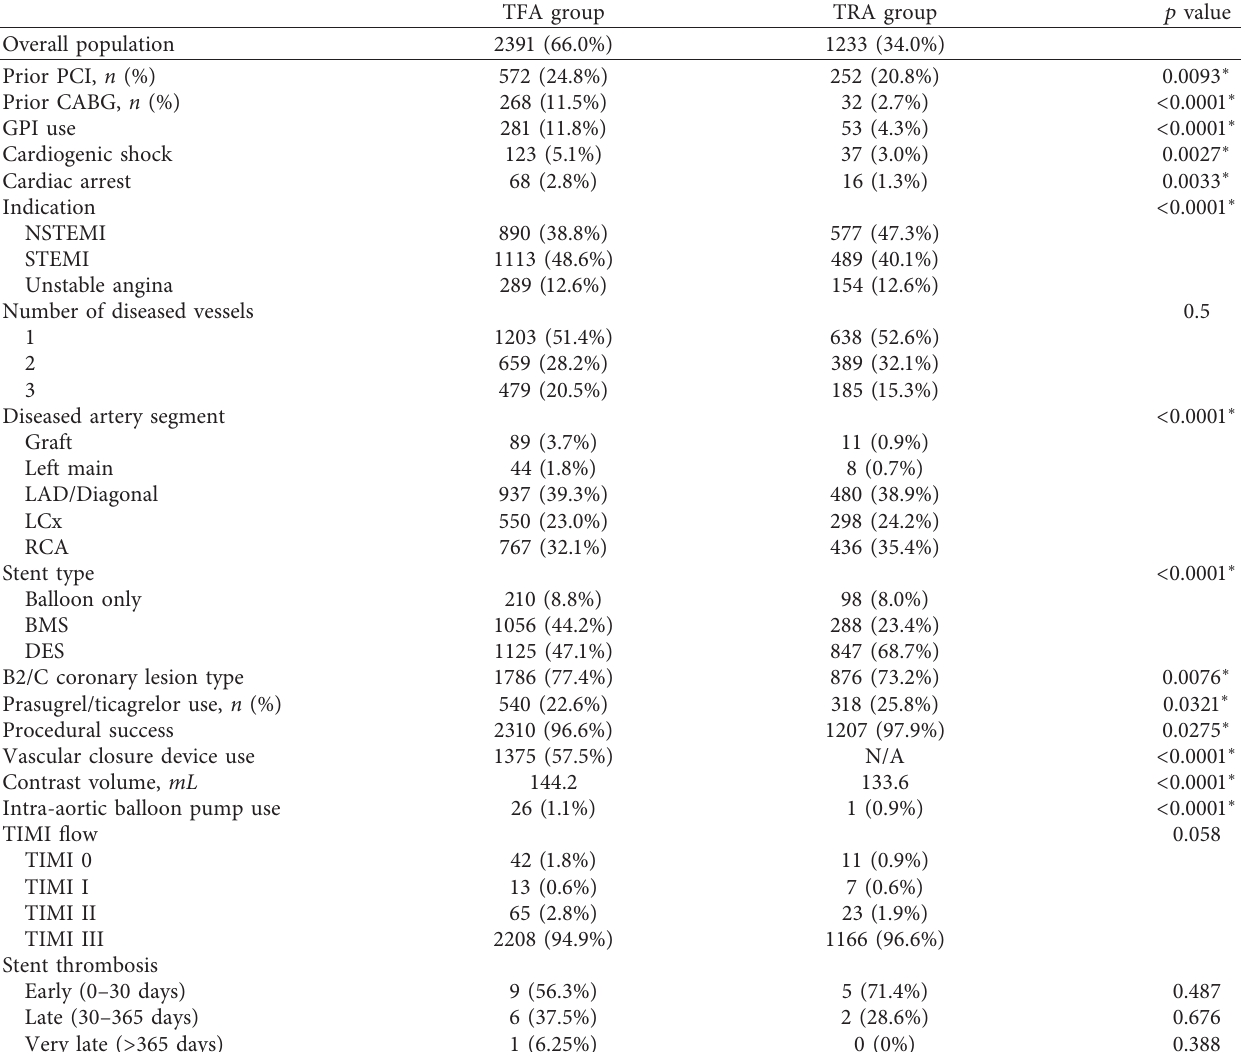
Table 2: Procedural